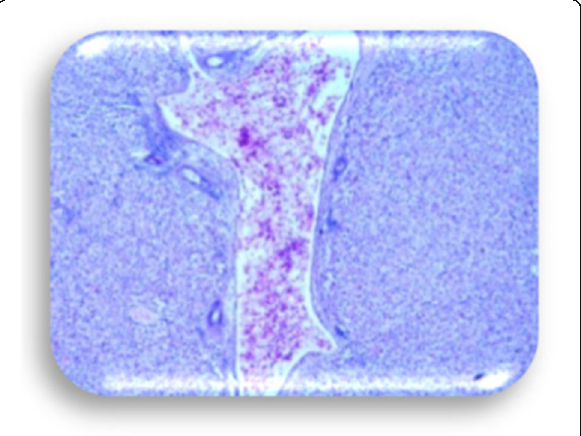
Fig. 2 Liver of chicken fed on formula 5% and 10% cactus